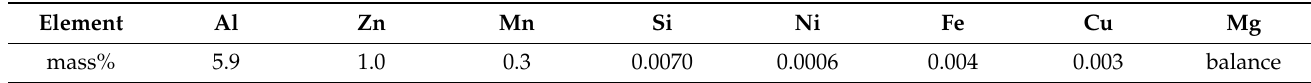
Table 1. Compositions of AZ61 magnesium alloy (mass%) used in this